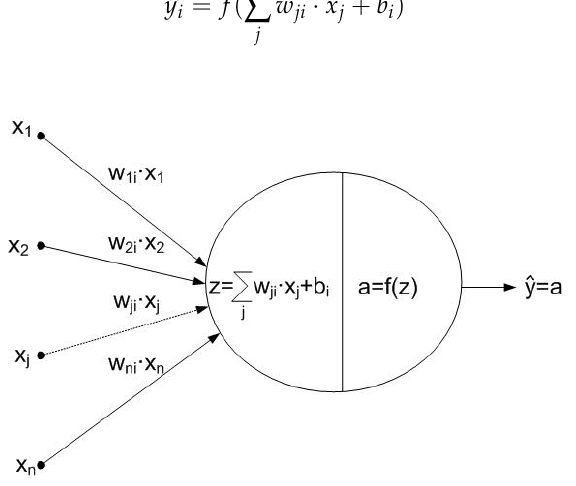
Figure 3. Node basic structure.